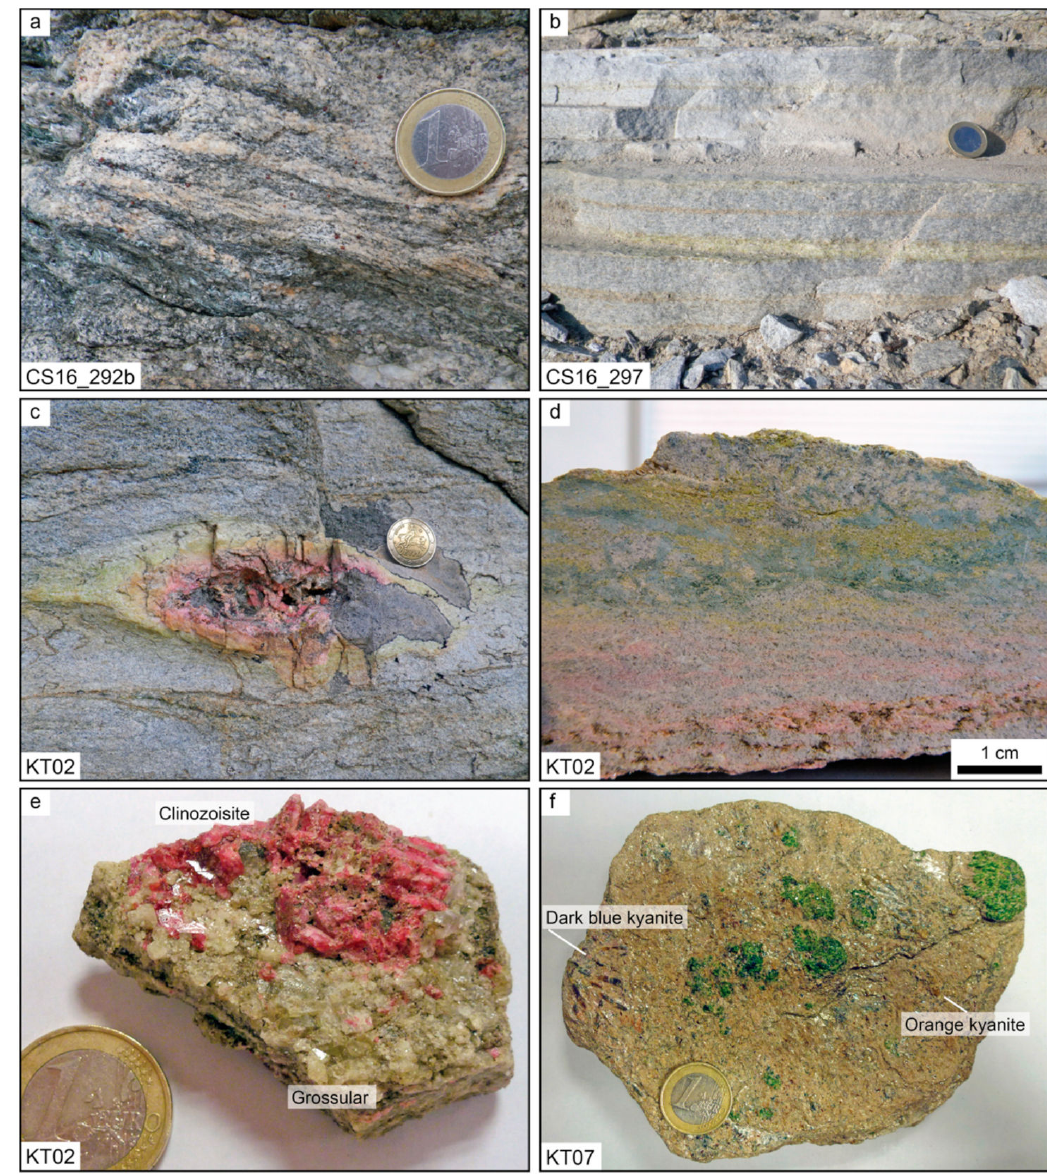
Figure 3. ( a ) Main garnet–kyanite–biotite–hematite–plagioclase ± staurolite ± sillimanite bearing gneiss of the Trikorfo area (sample CS16_292b, N290 / 65N). ( b ) Green epidote-rich horizon parallel to the main gneiss foliation (sample CS16_297, N270 / 11N). ( c ) Lense slightly oblique to the subhorizontal gneiss foliation showing a zonation of green epidote and pink clinozoisite together with grossular in a geode (sample KT02). ( d ) Mineralogical zonation with diopside, hornblende, epidote (green), grossular and clinozoisite (pink-red), sample KT02 equivalent to Th04. ( e ) Close up to the core of the geode to near gem-quality pink clinozoisite (clinothulite) and grossular association within locality sample KT02. ( f ) Deep green Mn-rich andalusite (viridine) and kyanite (deep blue and orange) association in sample